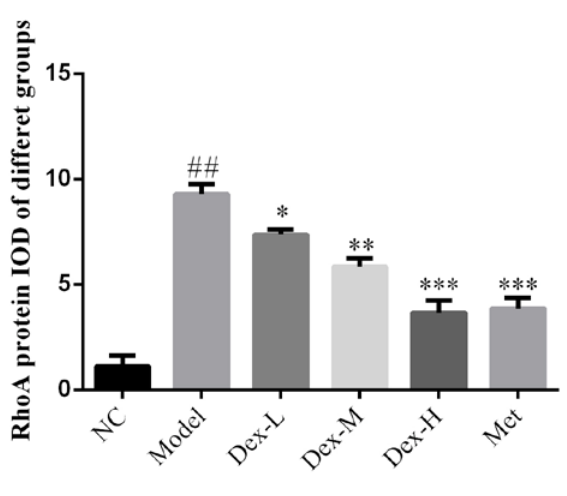
Figure 5: Comparison of RhoA protein expression in Kidney of Rats in Each Group NC: normal control group; Model: DN model group; Dex-L: Dex low- dose treated group; Dex-M: Dex medium-dose treated group;